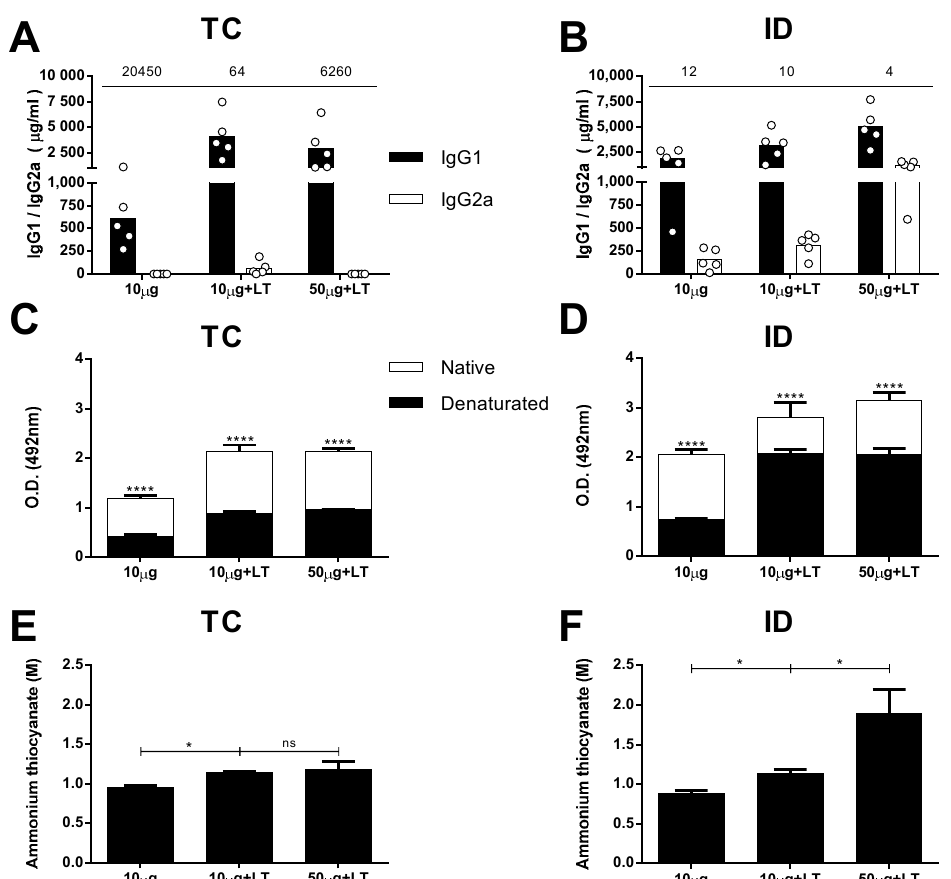
Figure 2. Serum antibody responses against DENV2 induced after TC or ID immunizations. DENV - specific serum antibody responses induced after TC and ID 3rd immunization doses, measured by ELISA with concentrated DENV particles as solid phase ( n = 5). ( A , B ) Serum IgG subclass responses in mice immunized via TC ( A ) or ID ( B ) routes. Values indicated above the lines represent IgG1 / IgG2a ratio, measured in each immunized group. ( C , D ) Binding of anti-DENV2 antibodies from serum samples of immunized mice via TC ( C ) and ID ( D ) routes to intact and heat-denatured virus particles. ( E,F ) Antigen binding a ffi nity of anti-DENV2 antibodies induced after immunization via TC ( E ) or ID ( F ) routes. Serum samples from mice submitted to TC ( E ) or ID ( F ) immunizations were tested by ELISA using di ff erent concentrations of ammonium thiocyanate as a dissociating agent. Statistical analyses were performed by two-way ANOVA in association with Bonferroni’s post-test * p < 0.05, **** p < 0.0001. Representative results of 2 independent experiments.